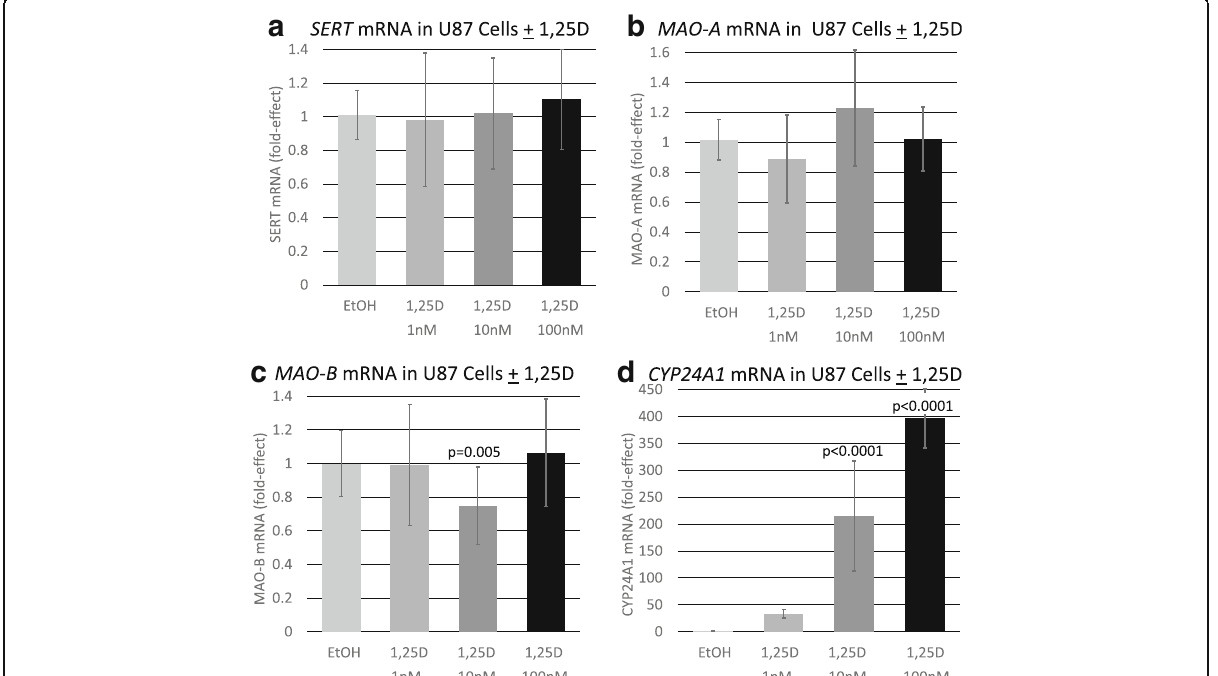
Fig. 2 Effect of 1,25D on serotonin degrading pathway and control mRNAs in U87 glioblastoma cells. P values listed at the top of bars represent statistical significance for comparison between 1,25D-treatment and ethanol vehicle control group in each and all cases. Statistical analyses were performed using ANOVA with a post hoc adjustment of P values via the Dunnett test that compares every mean to a control mean and takes into account the scatter of all the groups. a Expression of SERT in U87 human glioblastoma cells treated with 1,25D. Each mRNA value is the average of seven biological replicates ± std. dev. b Expression of MAO-A in U87 human glioblastoma cells treated with 1,25D. Each mRNA value is the average of 11 biological replicates ± std. dev. c Expression of MAO-B in U87 glioblastoma cells treated with 1,25D. Each mRNA value is the average of 27 biological replicates ± std. dev. d Expression of CYP24A1 in U87 glioblastoma cells treated with 1,25D. Each mRNA value represents the average of seven biological replicates ± std.